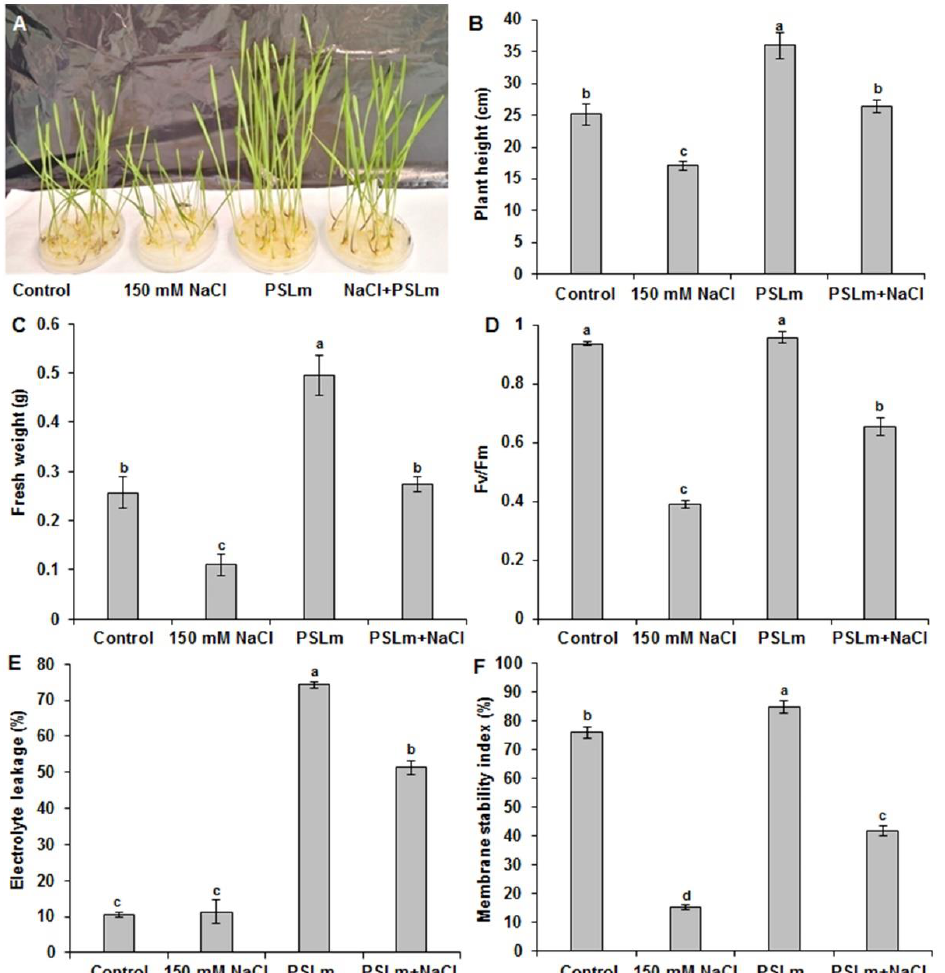
Figure 2. Effect of salt stress (150 mM NaCl) on plant phenotype ( A ), ( B ) plant height, ( C ) fresh weight, ( D ) chlorophyll fluorescence (Fv/Fm), ( E ) electrolyte leakage, and ( F ) membrane stability index of wheat seedlings in half-strength MS medium supplemented with (2 mg/mL) or without PSLm extract for 20 days. Values are means ± SE of three replicates. Different letters indicate significant differences at p < 0.05.